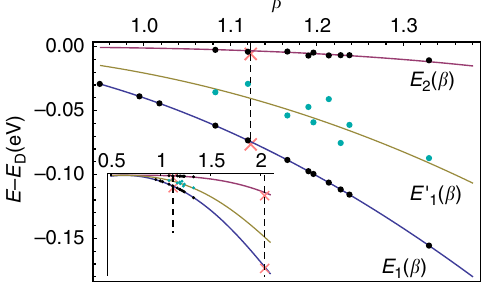
Fig. 5 Behavior of the energies E n ( β ) of the quasi-bound state spectrum. The curves are obtained from (2) for E 1 ( β ), E ′ ( β ), E 2 ( β ) as adapted to the 1 massless Dirac case. The black and cyan dots correspond to the values measured in graphene. The two pink x ’ s are the values of E fi mov energies measured in Caesium atoms 39, 47 , which corresponds to the (overcritical) fi xed E fi mov value β = 1.1236. Additional experimental points obtained in E refs 40, 41 are displayed in the inset